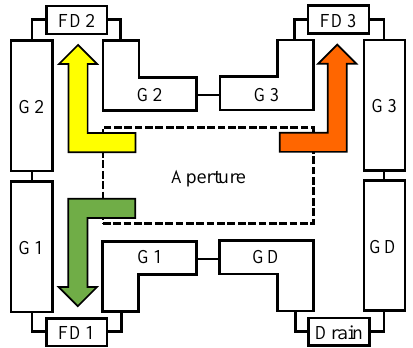
Figure 4. Single pixel structure in a multi-tap CMOS image sensor. The green, yellow and orange arrows represent the electron flows that are generated via the aperture. The colors of the arrows correspond to the colors of the exposures shown in the bottom section of Figure 3. We can select the floating diffusion (FD) in which the electrons are to be stored by changing the gate